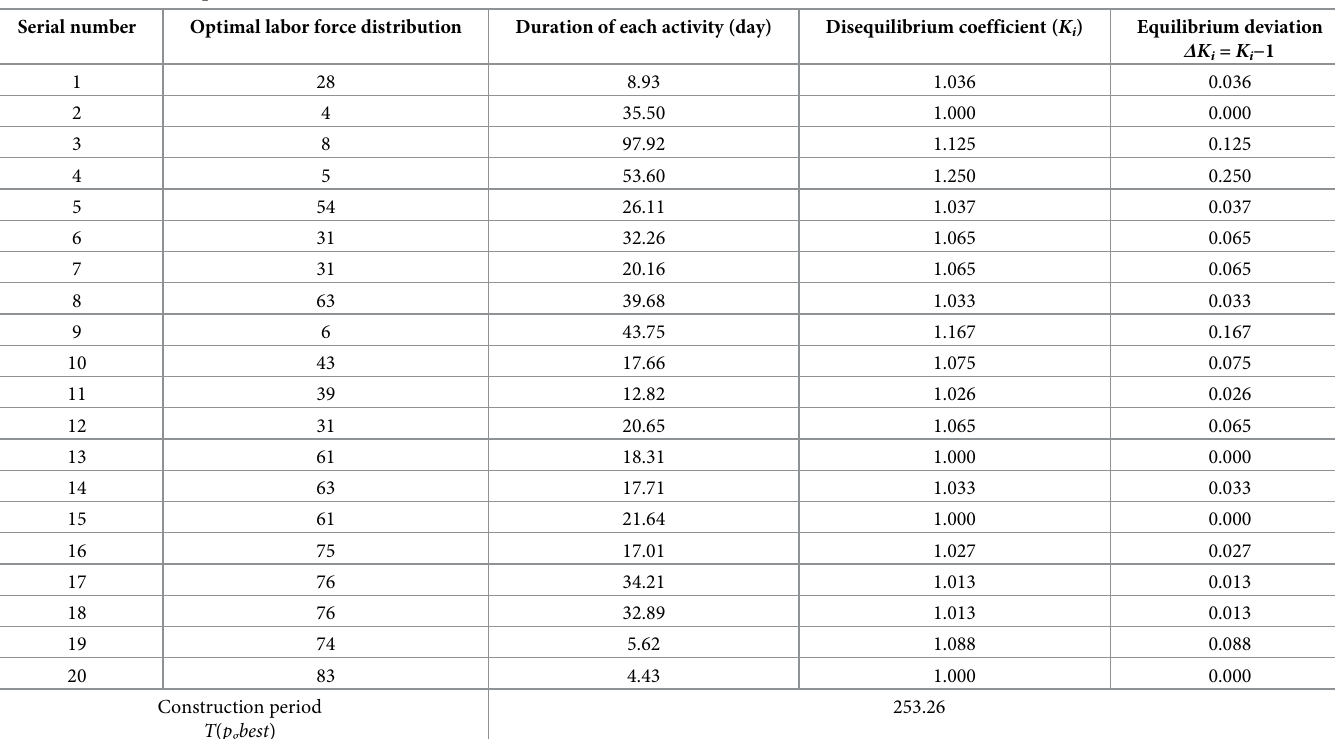
Table 3. Calculation output results.